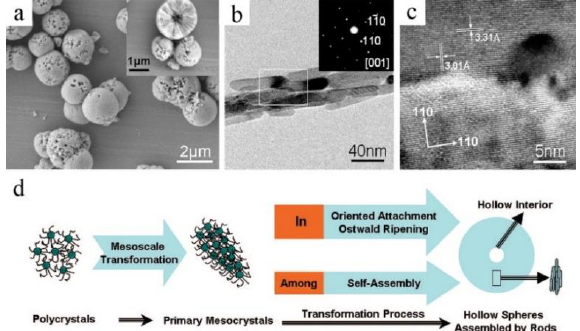
Figure 6. ( a ) SEM, ( b ) TEM, and ( c ) HRTEM images of hollow spheres of rutile TiO 2 mesocrystals. The inset in ( a ) is a magnified SEM image and the inset in ( b ) shows the related SAED pattern. ( d ) Schematic illustration of the formation mechanism of the rutile TiO 2 mesocrystals. Reprinted with permission from [46]. Copyright American Chemical Society, 2009.